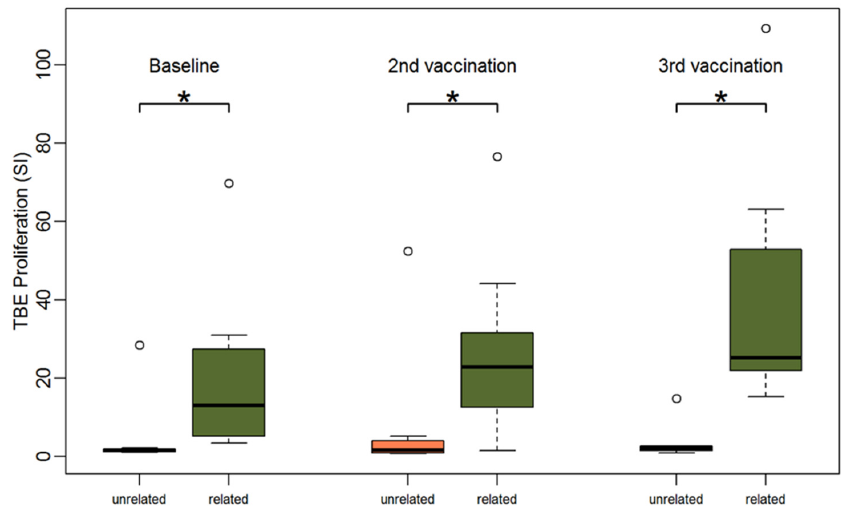
Figure 5. Boxplots showing the median and distribution of lymphocyte proliferation as detected by thymidine incorporation assay (the stimulation indices are given) at three different time points for patients with unrelated (orange) and related donors (green) after stimulation with TBE antigen. Asterisk marks significant p -value (baseline: p = 0.004; 2nd vaccination: p = 0.015; 3rd vaccination: p = 0.002).